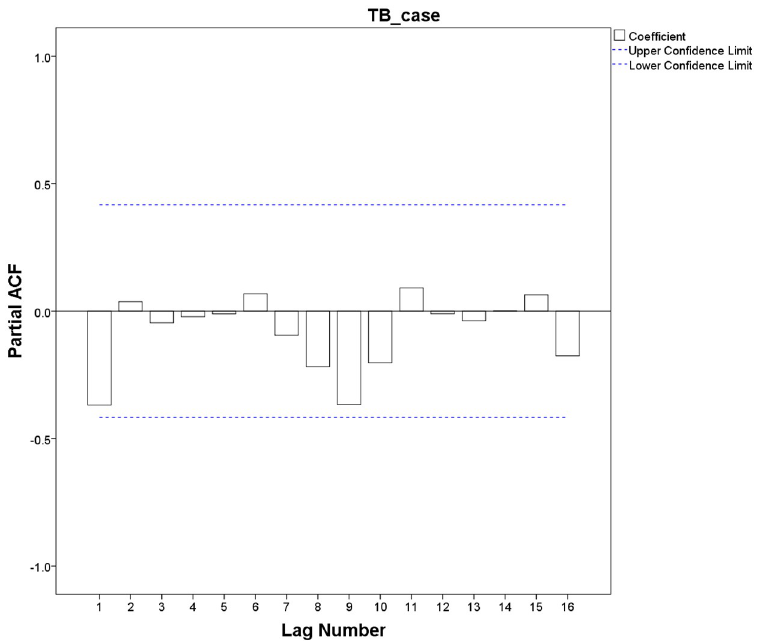
Fig 6. Plot of PACF after a differenced TB cases time series.